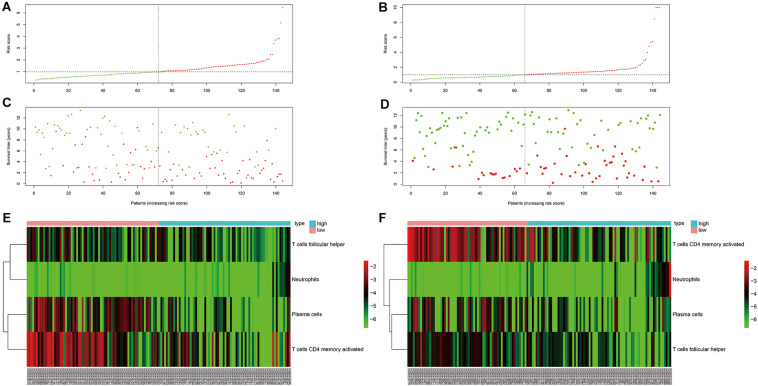
Risk curve and heatmap grouped according to risk score in the training and testing cohorts. (A,C,E) Risk curve and selected immunocyte populations in the training cohort. (B,D,F) Risk curve and selected immunocyte populations in the testing cohort.